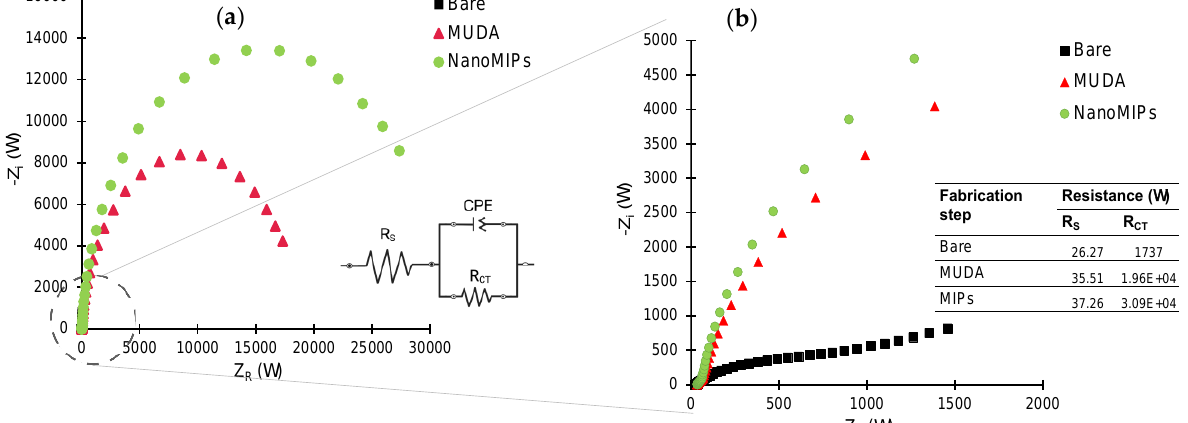
Figure 7. ( a ) Nyquist plots of the data obtained for bare gold electrode, MUDA and nanoMIP immobilization with inset equivalent circuit. ( b ) Zoomed Nyquist plots with inset table of resistivity of the solution (R s ) and charge transfer resistance (R CT ) of the circuit.